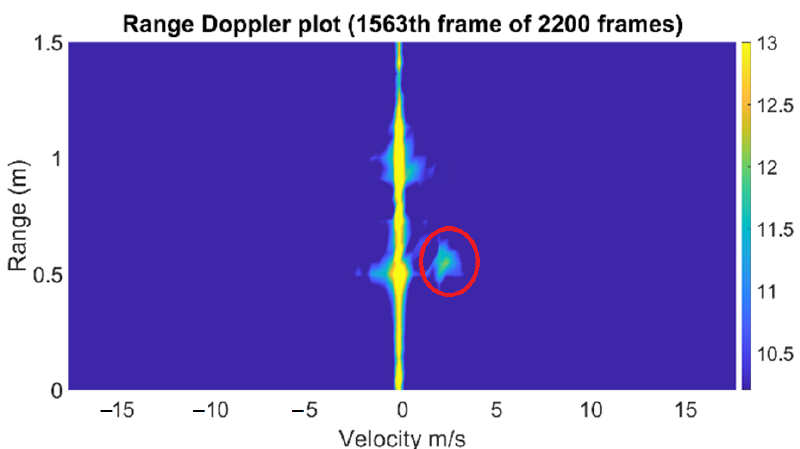
Figure 5. The range-Doppler diagram of water from a dummy bladder. The red circle shows the detected water from the dummy bladder.